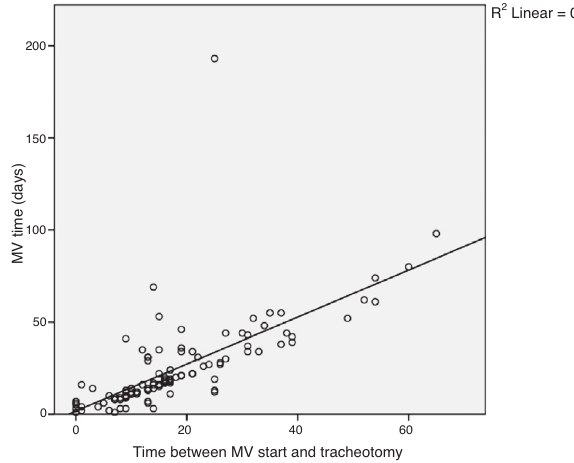
Figure 3 Spearman’s correlation: correlation was found between the duration of mechanical ventilation (MV) and timing of tracheotomy (time between MV start and tra- cheotomy) − R 2 = 0.46.